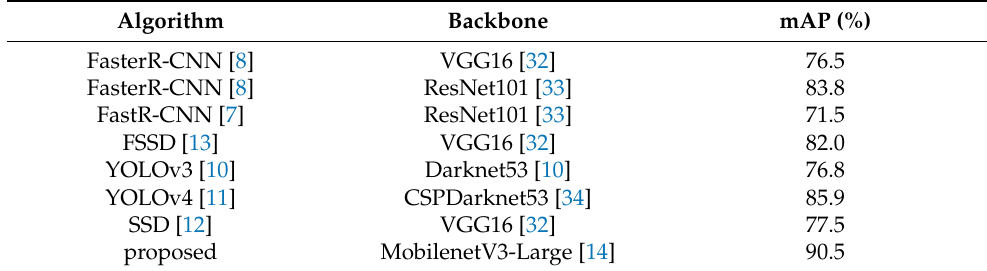
Table 1. The comparison results of mAP in the test sets.